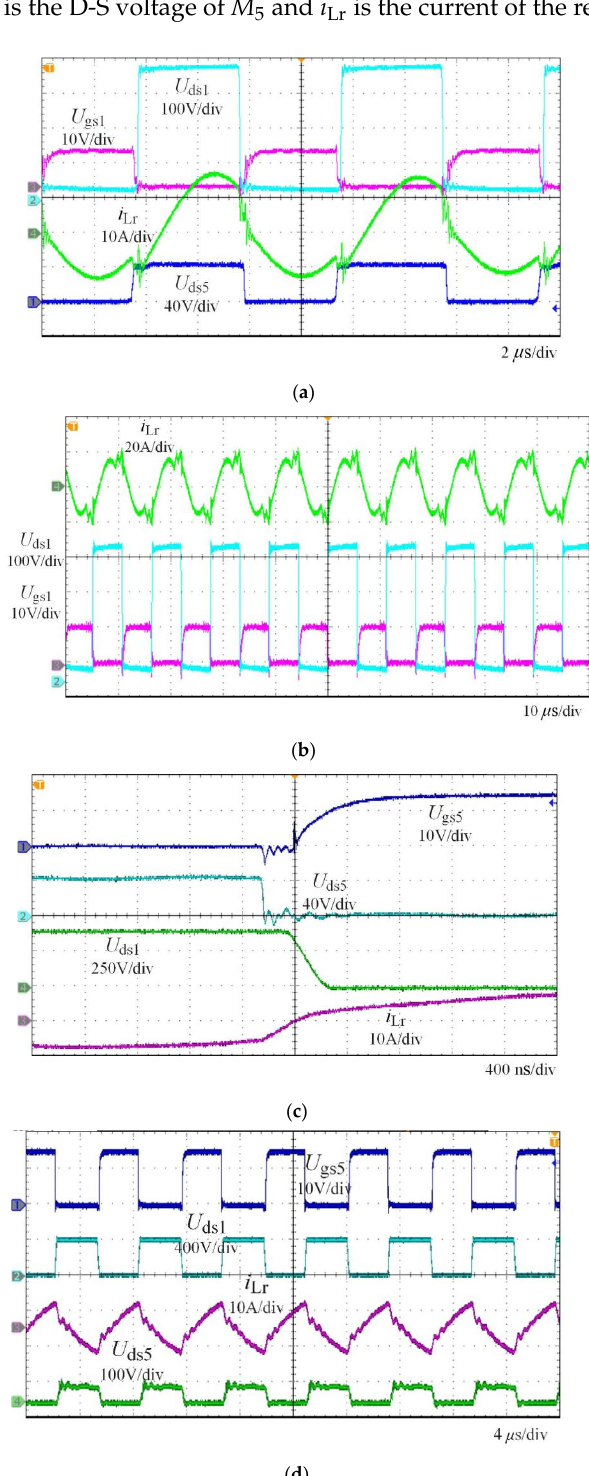
Figure 15. Experimental results of the prototype converter: ( a ) working frequency is 125 kHz, and load is 1 Ω , step-down mode; ( b ) working frequency is 90 kHz, and load is 2.5 Ω , step-down mode ( c ) ZVS in step-up mode; ( d ) working frequency is 160 kHz, and load is 1.4 Ω , step-down mode.